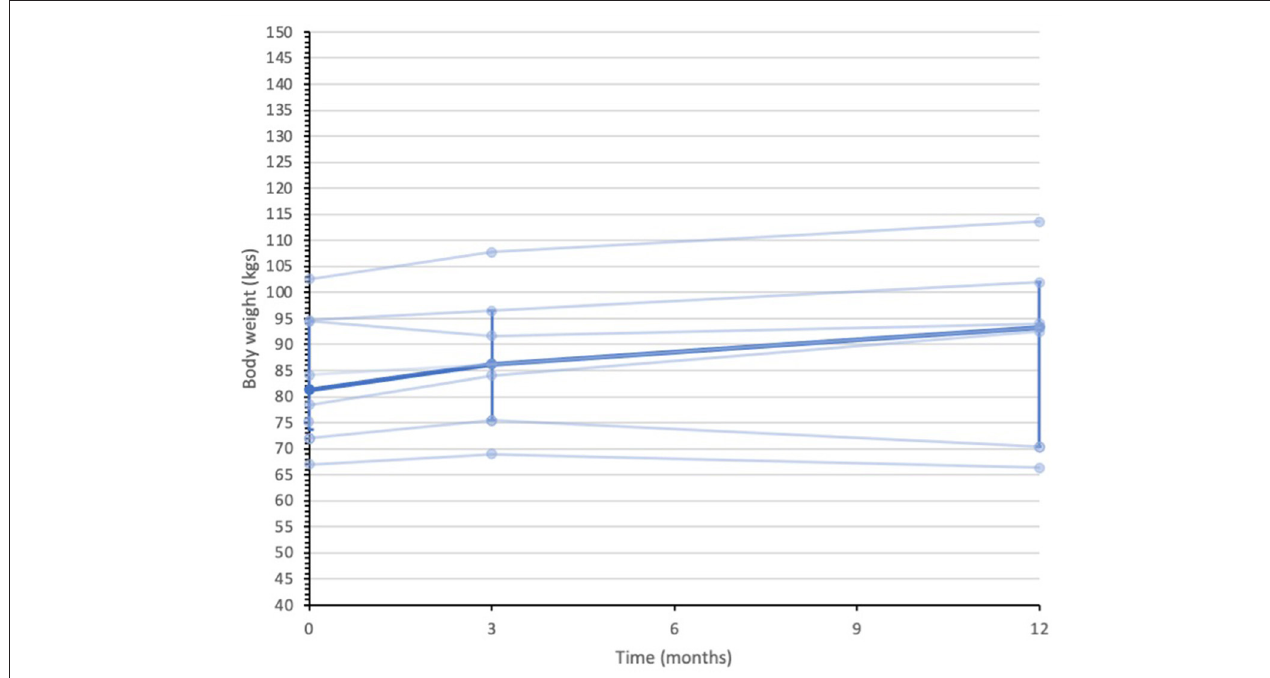
FIGURE 3 | Data series of individual and median body weight values for UC participants ( n = 8). Individual data series for participants in the usual care group are depicted by the pale blue lines. Median depicted by darker blue line, with IQR error bars. Median was calculated from all recorded data at each assessment point. n = 8 at baseline, n = 7 at 3-months, and n = 7 at